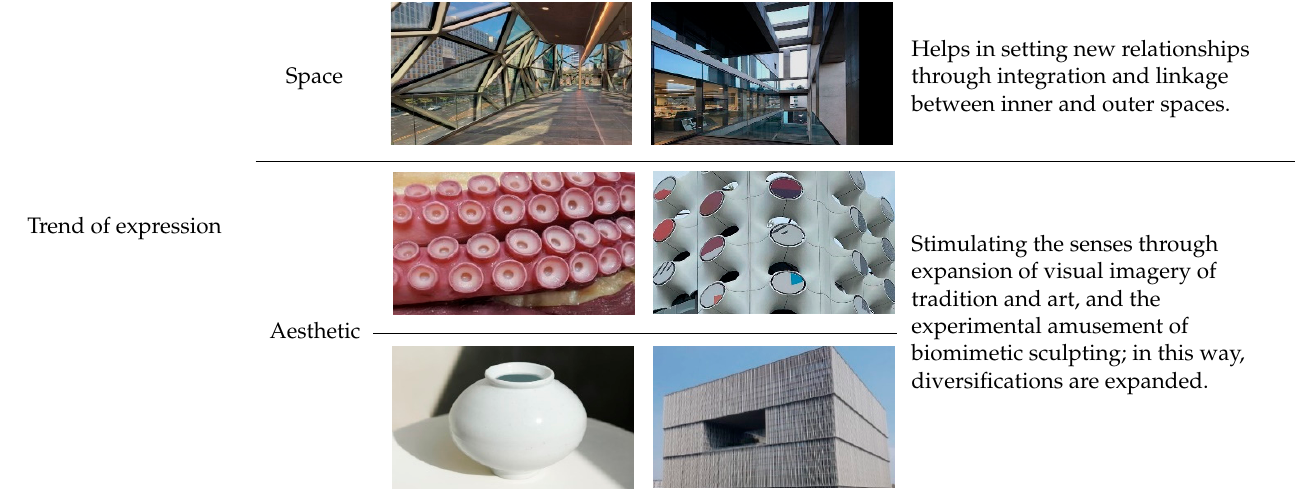
Table 11. Trends of expression for each assessed element.